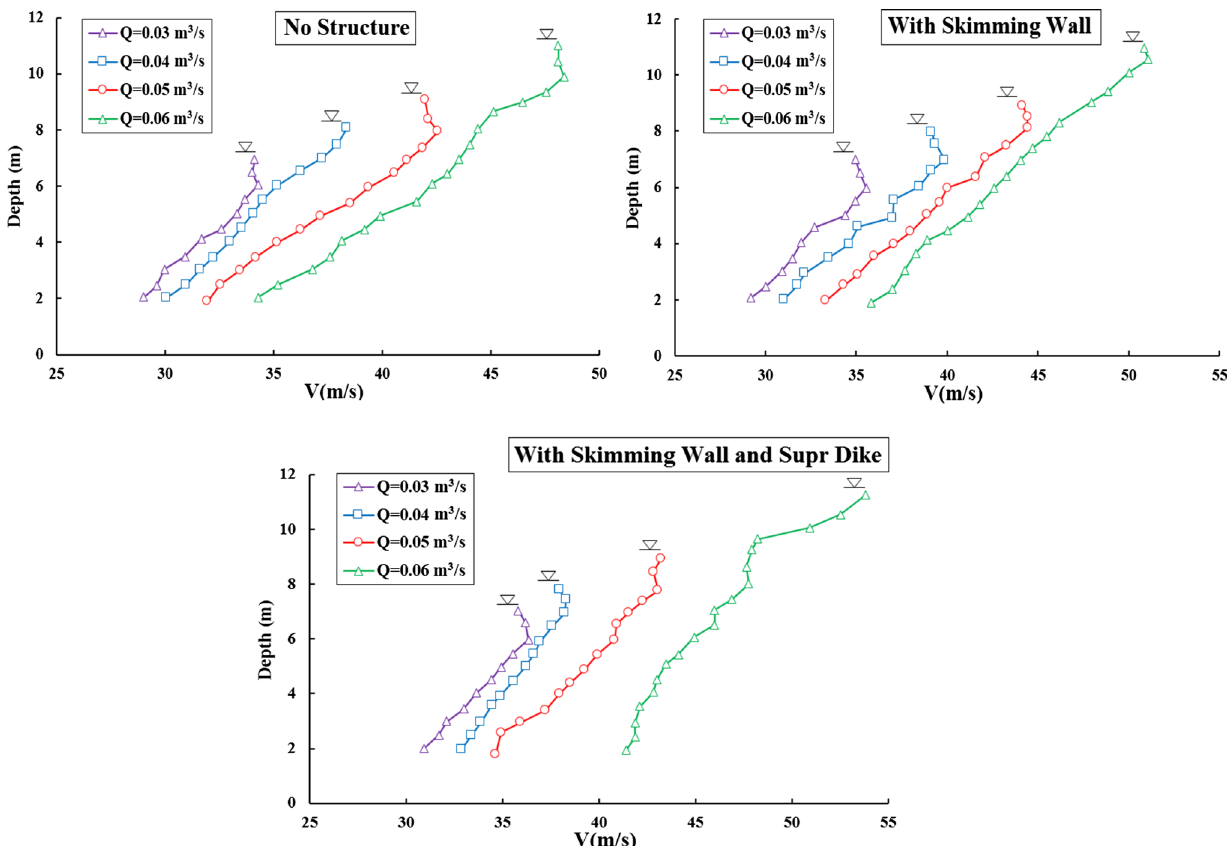
Fig. 12 Velocity distribution near the